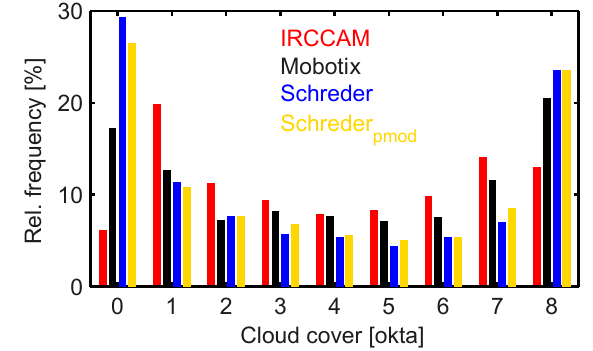
Figure 5. Relative frequencies of the determined cloud coverage at Davos (during daytime). Zero okta: 0–0.0500, 1okta: